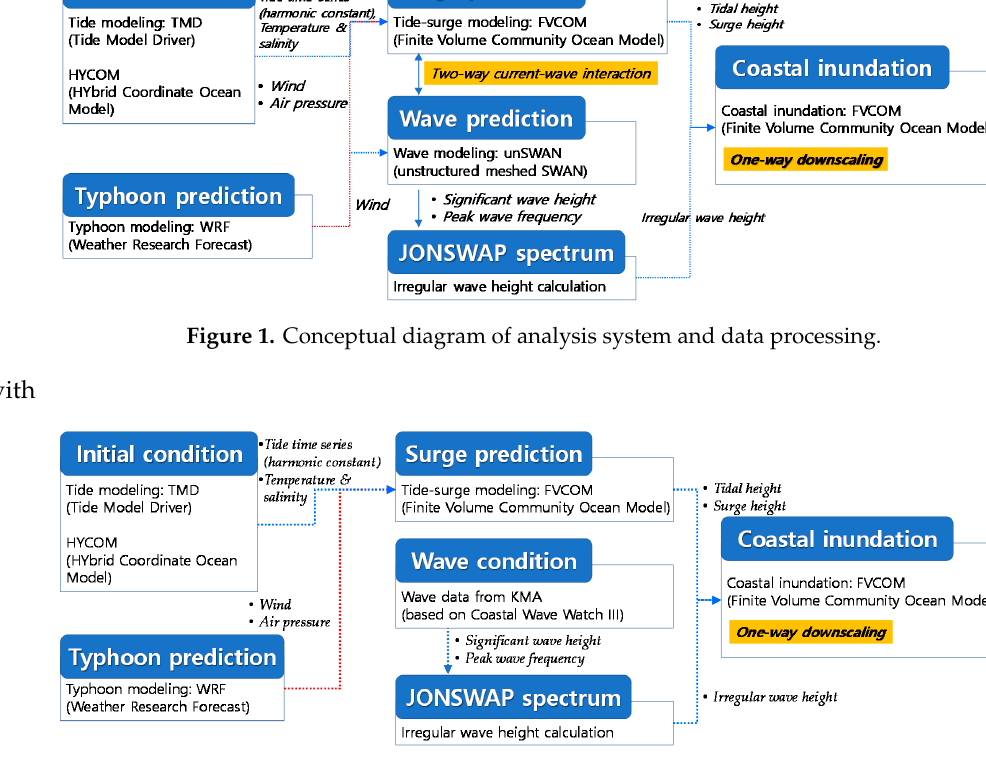
Figure 1. Conceptual diagram of analysis system and data processing .